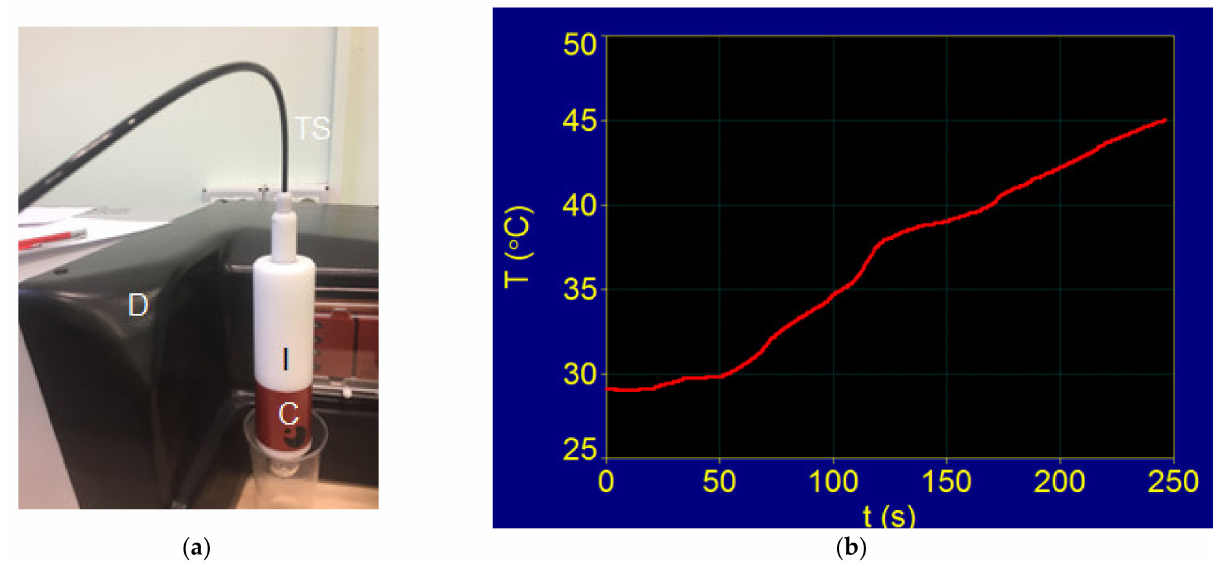
Figure 14. ( a ) Calorimetric system for measuring the temperature in a magnetic suspension with nanoparticles during magnetic hyperthermia; D: magnetic hyperthermia driver, C: inductor coil, TS: fiber optic temperature sensor, I: thermal insulation surrounding the vacuum chamber; ( b ) T–t experimental diagram of the magnetic suspension of Fe 3 O 4 -PAA for 10